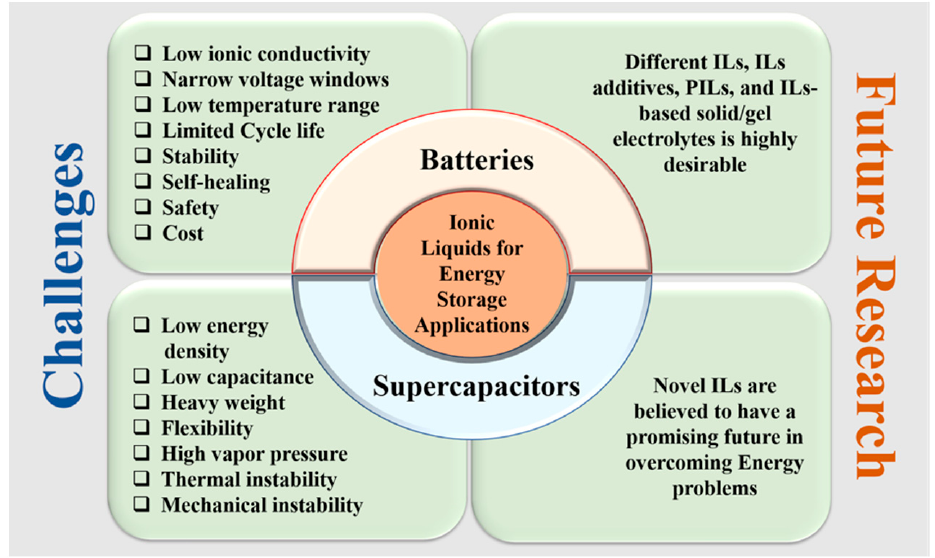
Figure 10. Challenges and future research on ILs for energy storage applications.